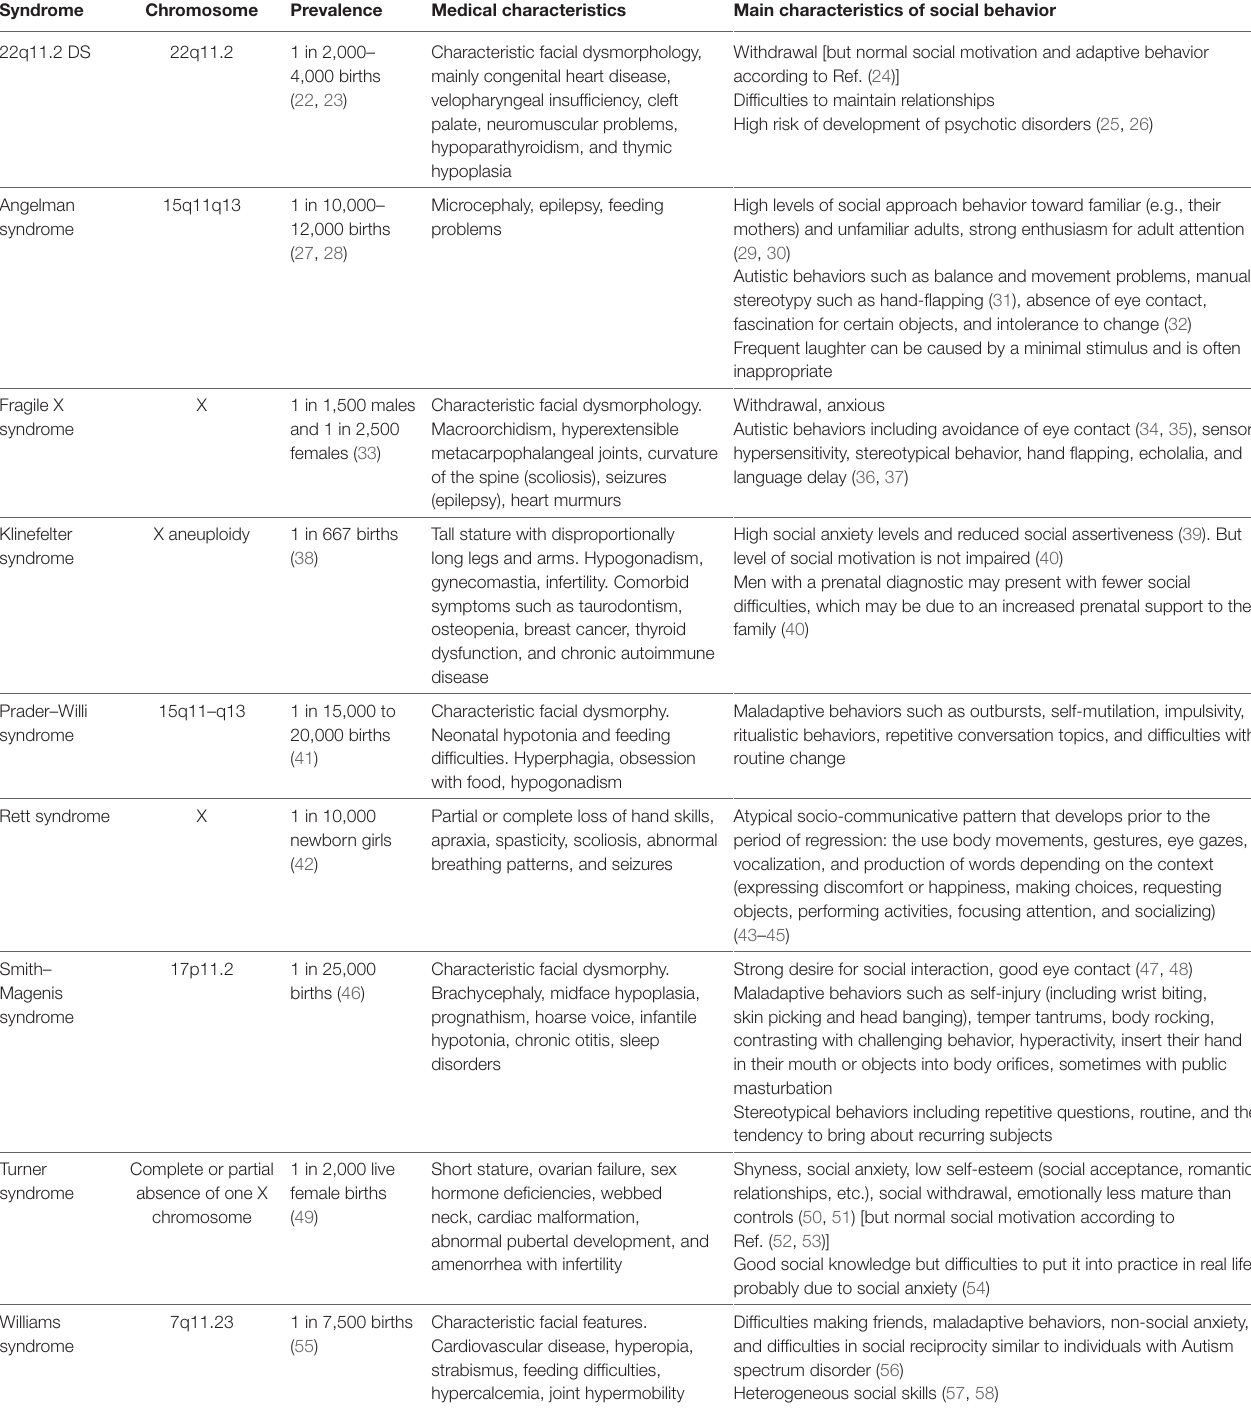
TAbLe 1 | Summary presentation of the main medical and social characteristics of the neurodevelopmental syndromes cited in this